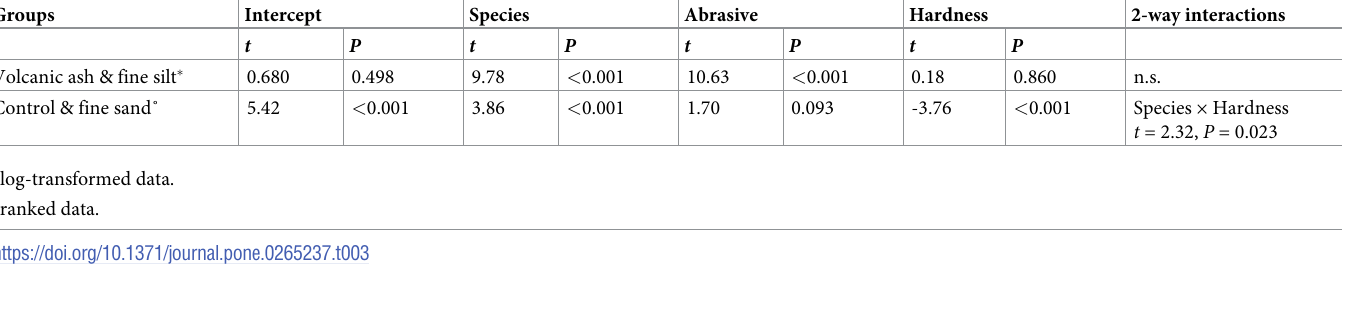
Table 3. Results of general linear models assessing the effects of species, abrasive and enamel hardness on enamel height loss after a standardized brush test.